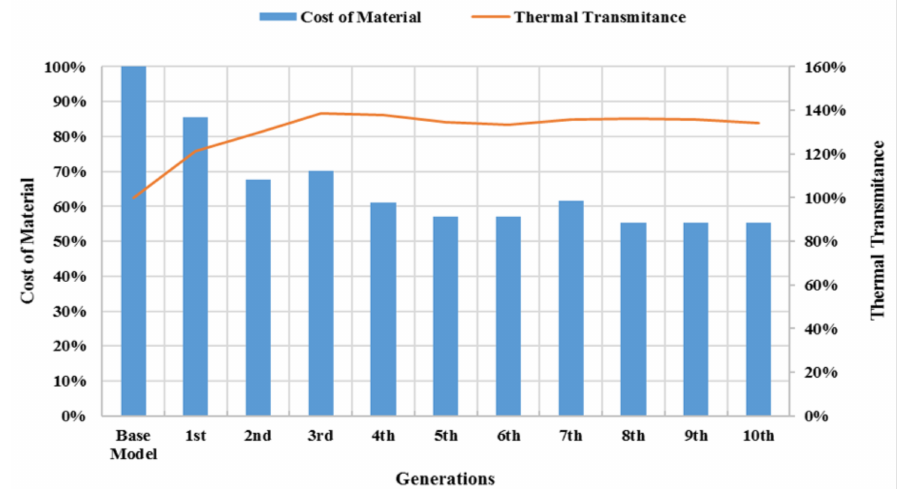
Figure 12. History of CSP cost and thermal resistance in GA